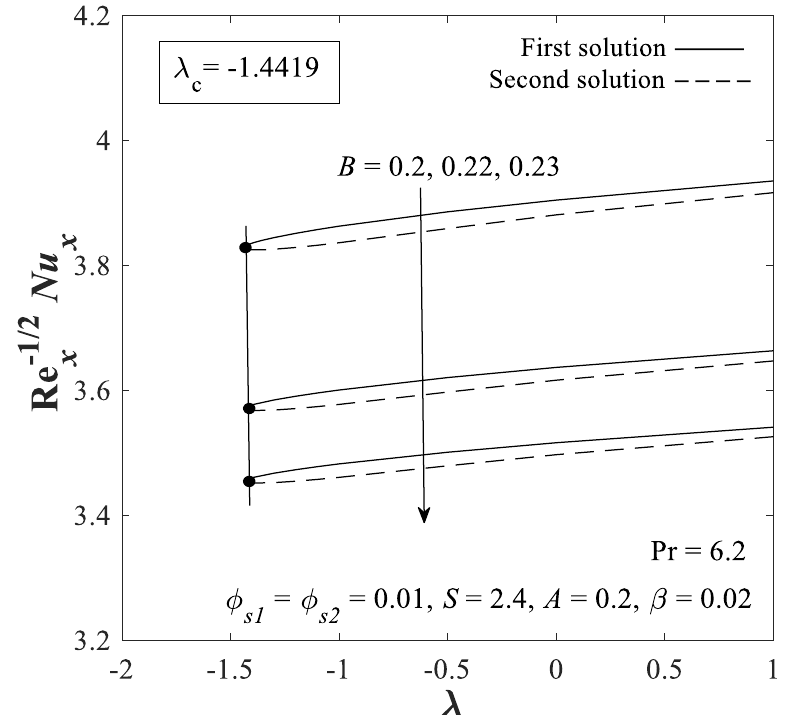
Figure 3. Plot of  1/2 Re